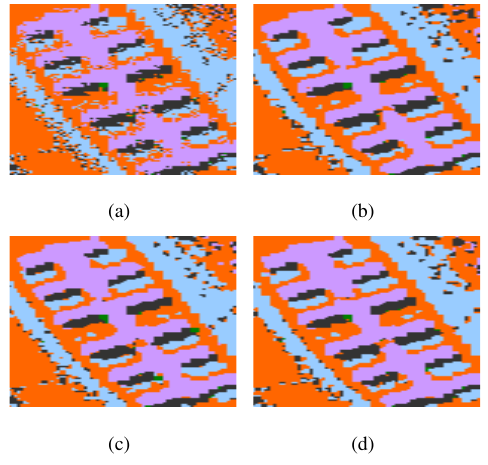
Figure 6. Subpixel mapping results of three algorithms : (a)